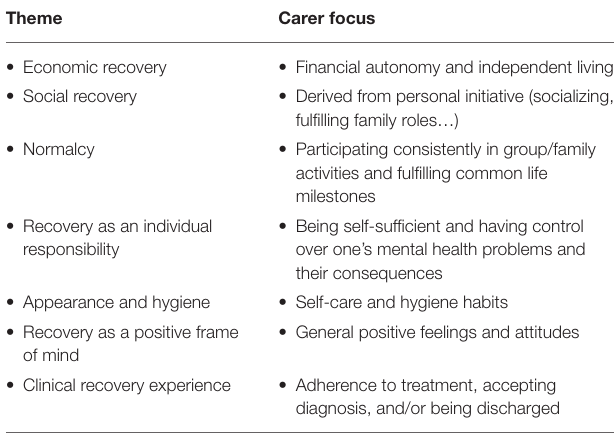
TABLE 3 | Themes present in caregivers’ understandings of